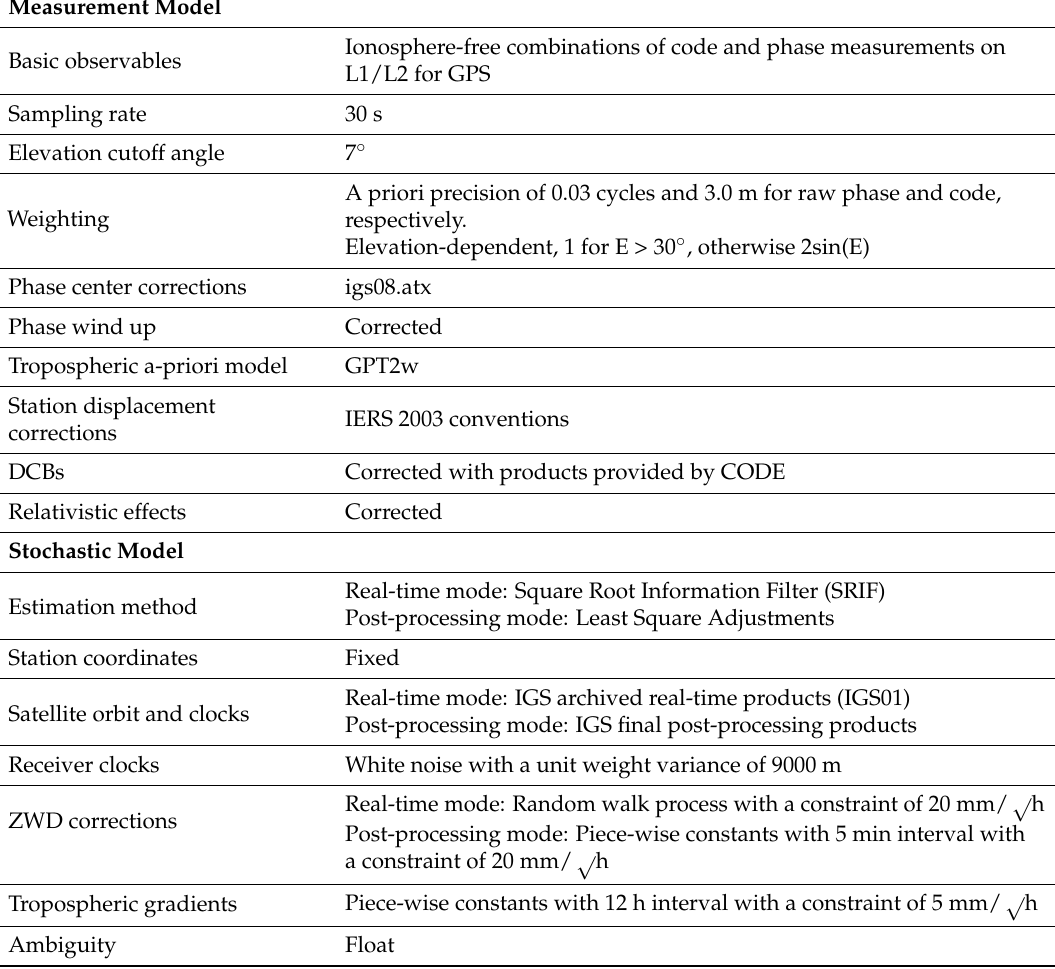
Table 2. GPS data processing strategy.